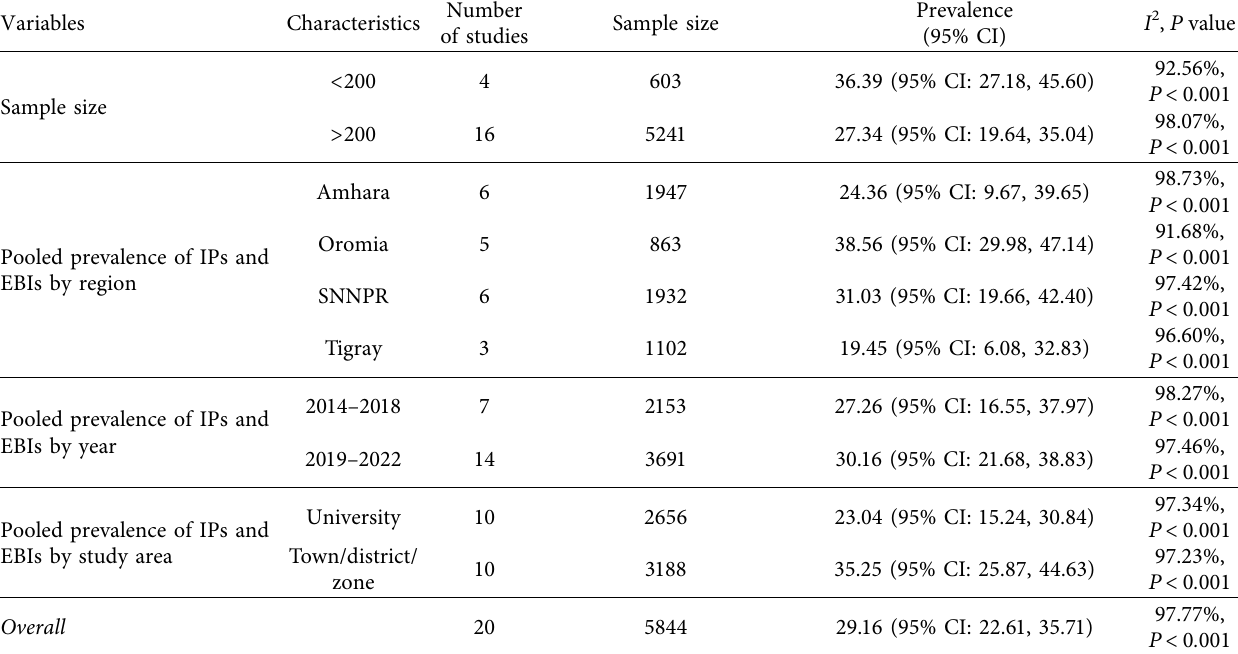
Table 3: Prevalence of IPs and EBIs among food handlers in Ethiopia by subgroup